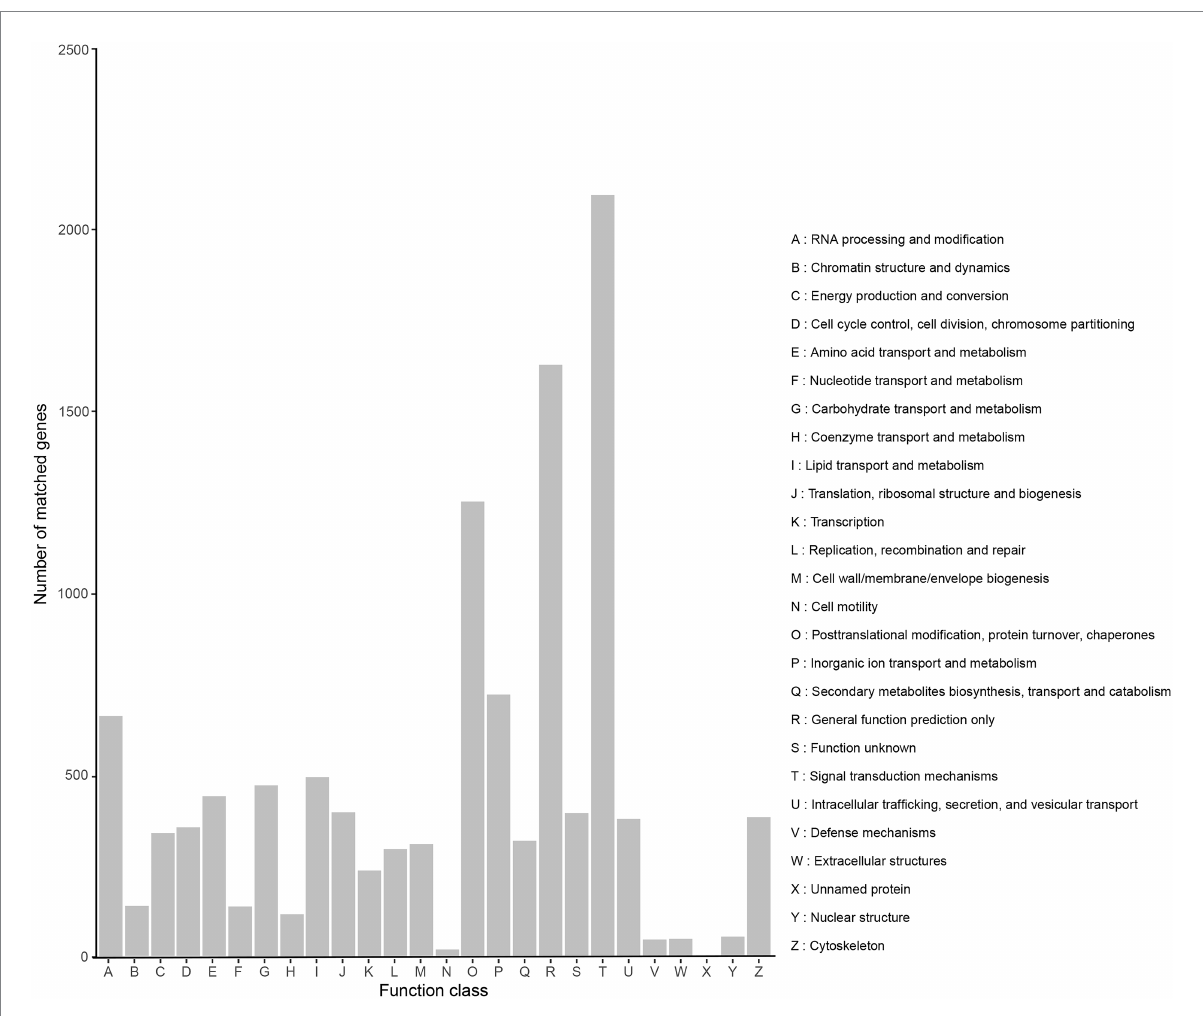
FIGURE 4 KOG classification of high-quality transcripts of the Akashiwo sanguinea full-length